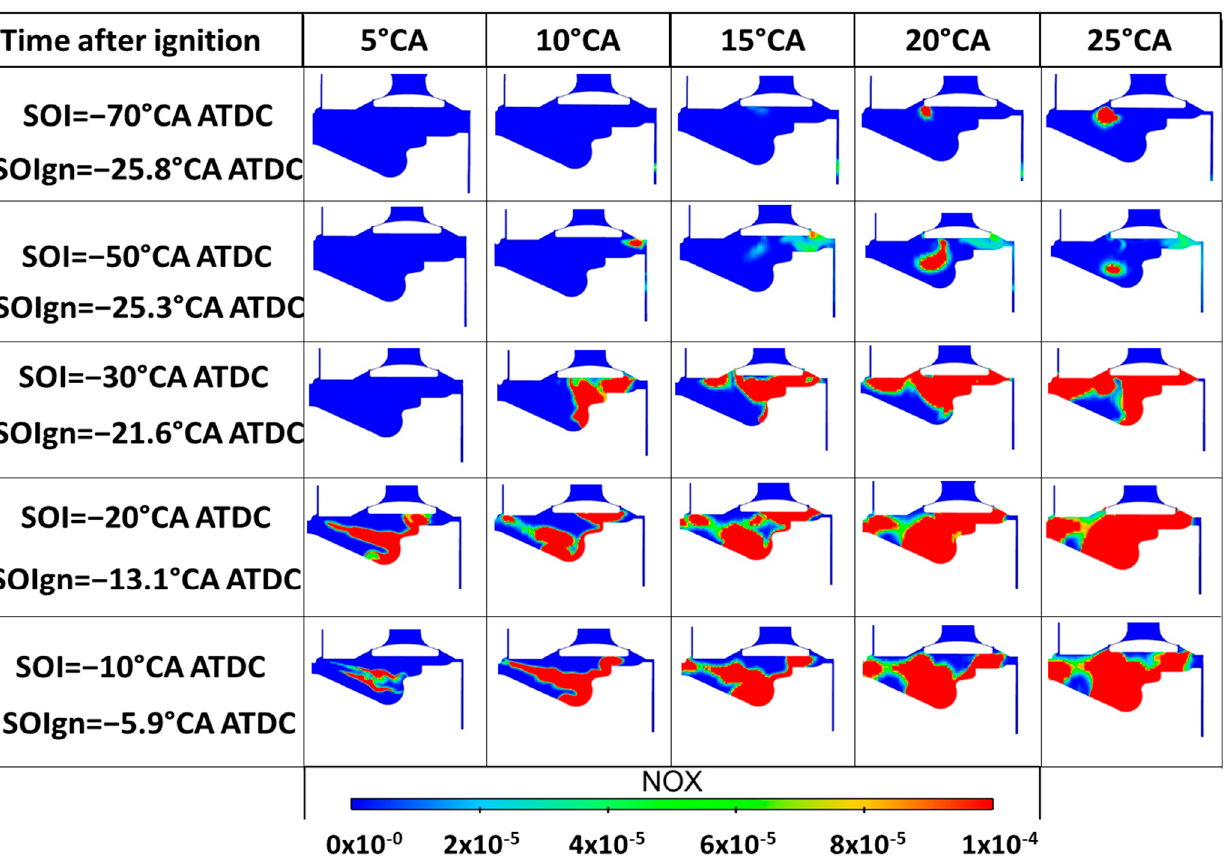
Figure 21. Time histories of NO x mass fraction contour plot in a plane formed by the cylinder axis and a spray axis according to °CA after SOIgn for various SOI timings.